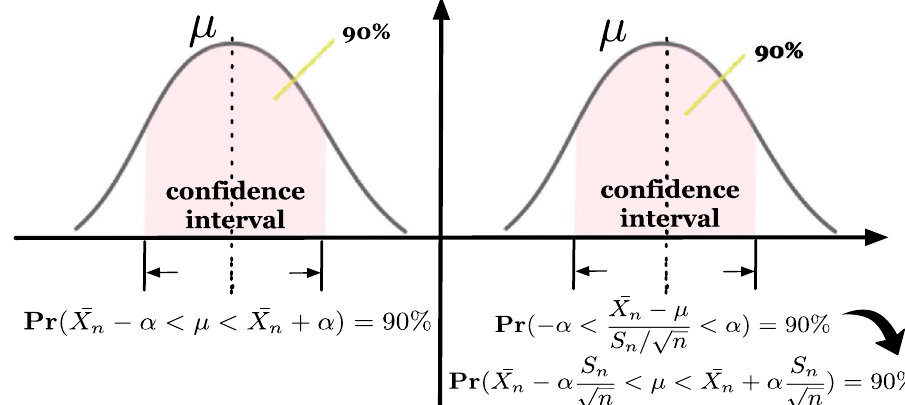
Fig. 3 Example of confidence